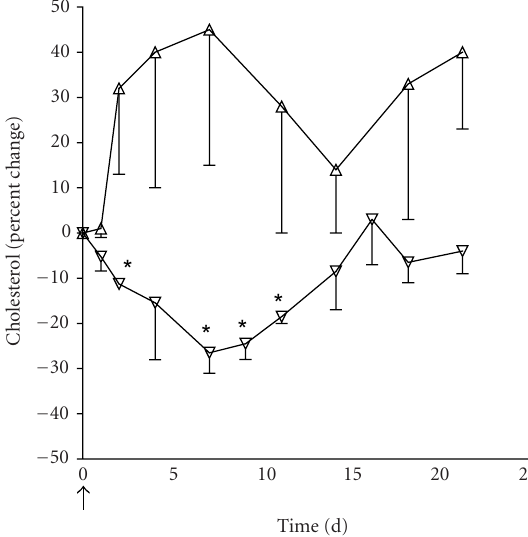
Figure 4. Average percent change in HDL ( ∆ ) and VLDL + LDL ( ∇ ) cholesterol concentrations in baboons after sub- cutaneous injections of the truncated apoC-I peptide at 10, 15, and 20 mg/kg on days 0, 7, and 14, respectively (arrows). The baboons were fed the HCHF diet. Values are expressed as mean ± SE, n = 3. Values significantly di ff erent from those at day 0 are marked by an asterisk ( P < .